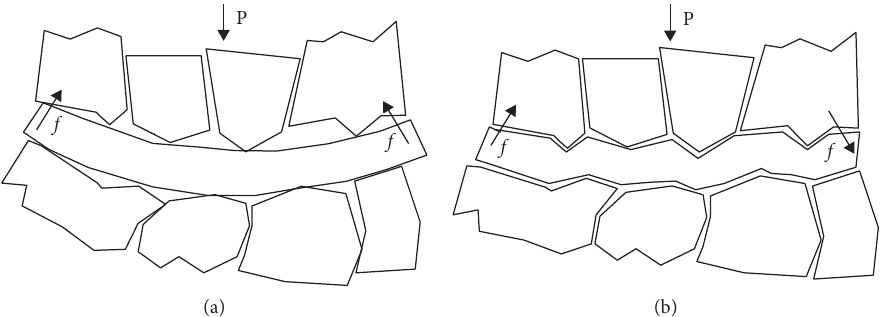
Figure 14: Changes of external loads on tire slices reinforced concrete particles.